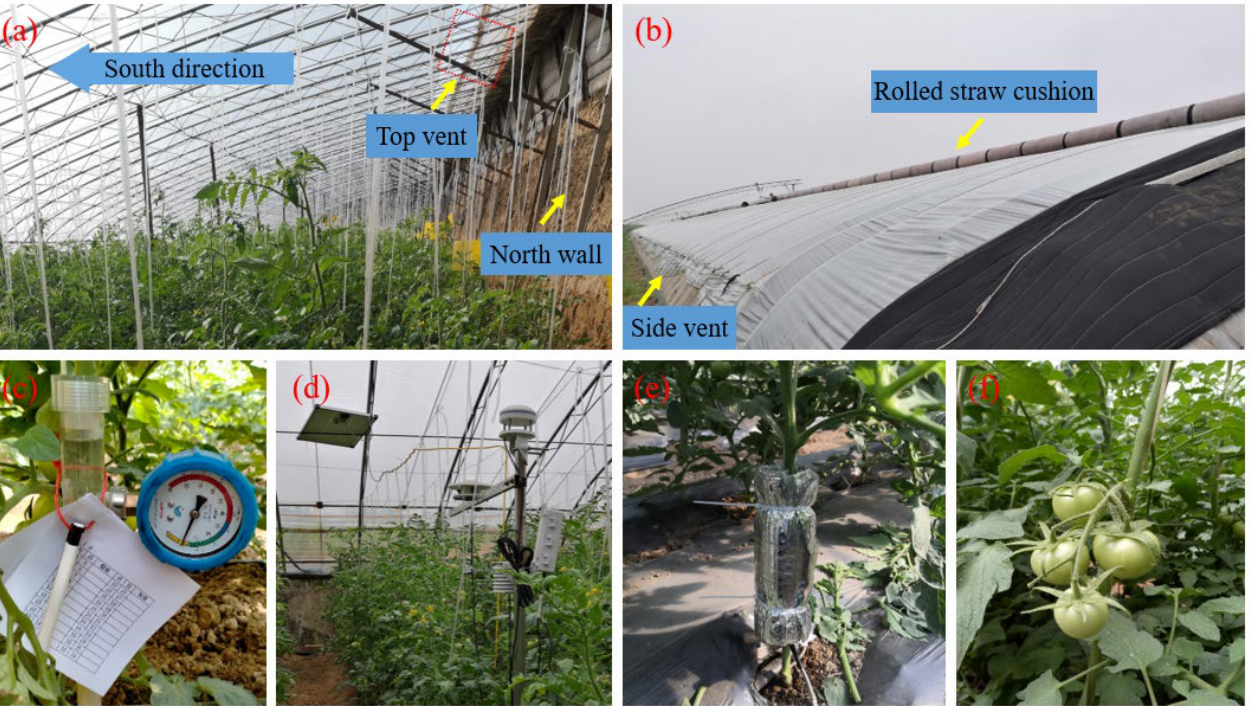
Figure 1. Photos of the sunken solar greenhouse. ( a ) inside view with tomato growth, ( b ) outside view in winter, with front plastic cover facing south and the rolled straw cushion placed on the top of the roof, ( c ) soil matric measurement using dial type tensiometer, ( d ) a view of the meteorological station, ( e ) a view of one set of sap flow gauge, and ( f ) a view of the growing tomato.